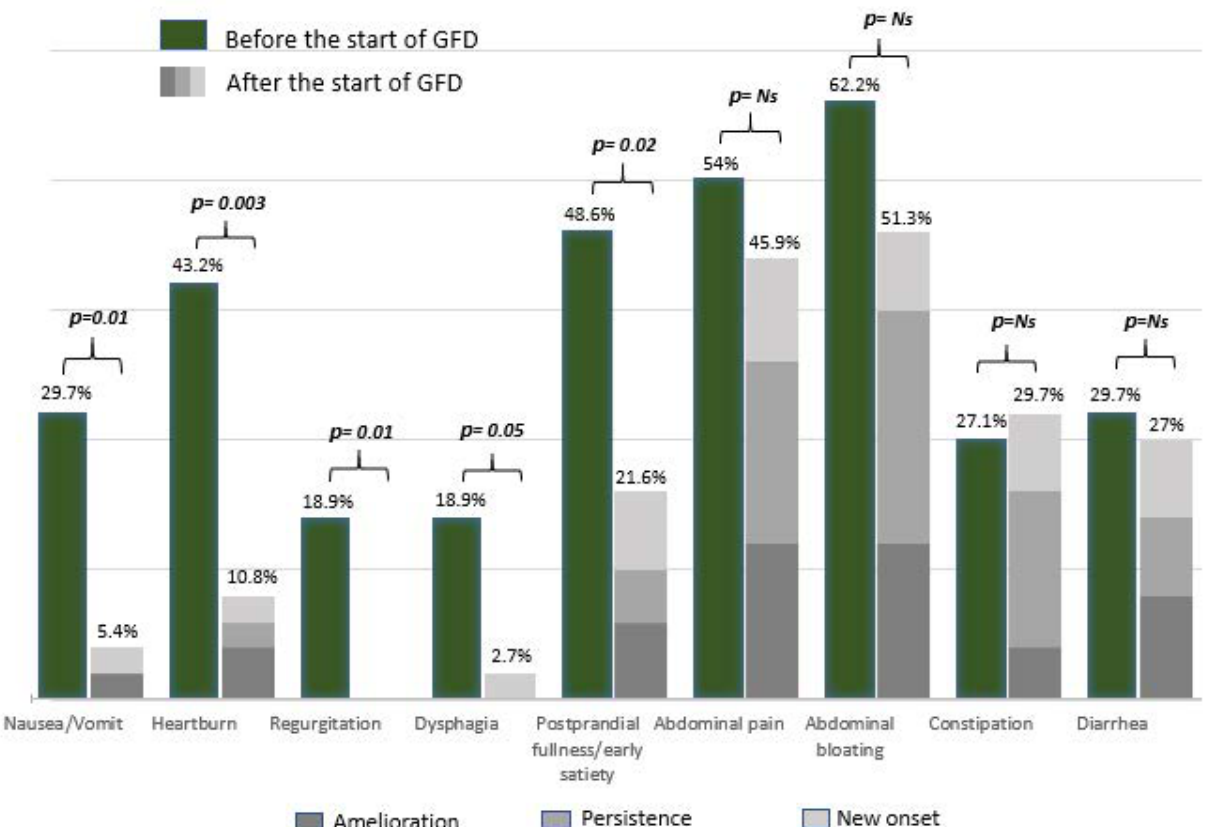
Figure 2. Trend of GI symptoms among patients with persistent GI symptoms/signs at the time of the histological re-evaluation. GFD = Gluten-free diet; Ns = Not significant. Table 3. Comparison of GFD duration, clinical and serological features among patients with (Marsh 3) or without